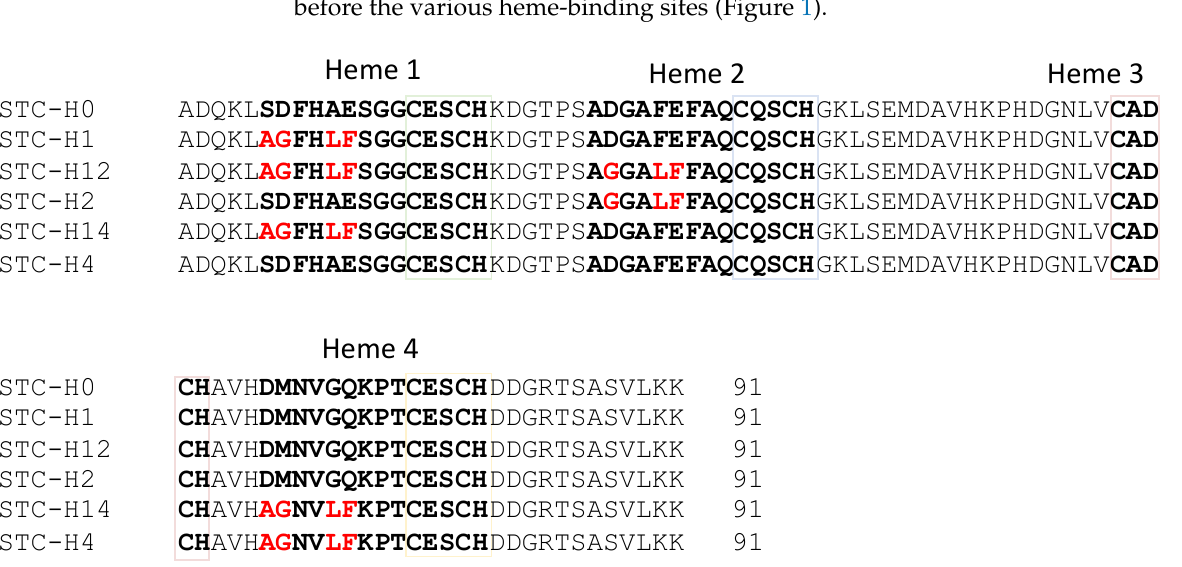
Figure 1. Amino acid sequence of the different STC mutants with mutated residues highlighted in red. Amino acids in bold highlight the recognition sequence and heme-binding motif of the hemes that were mutated.